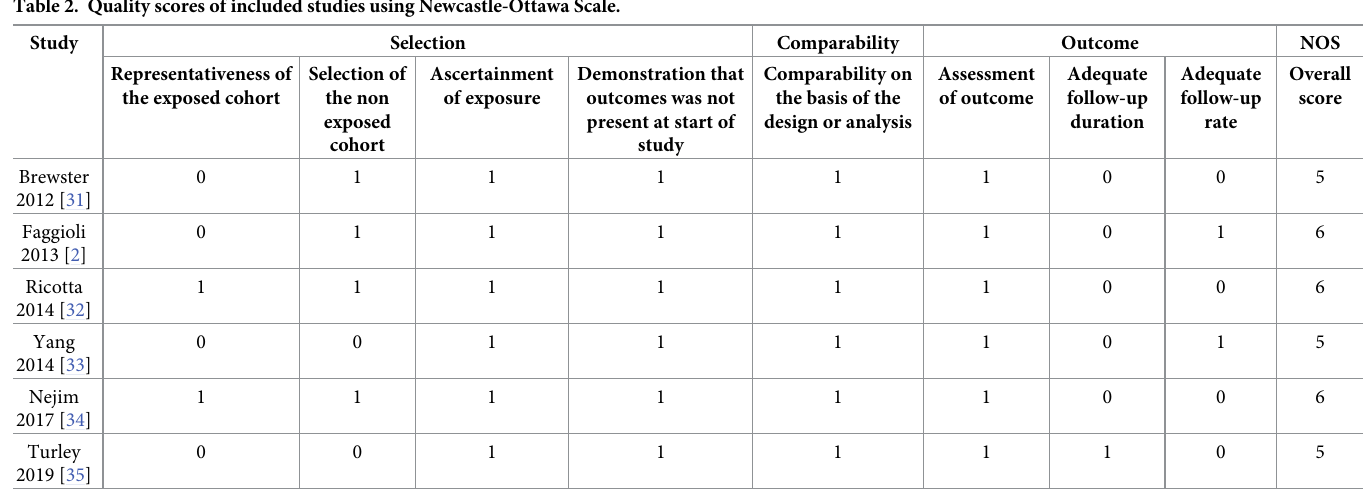
Table 2. Quality scores of included studies using Newcastle-Ottawa Scale.